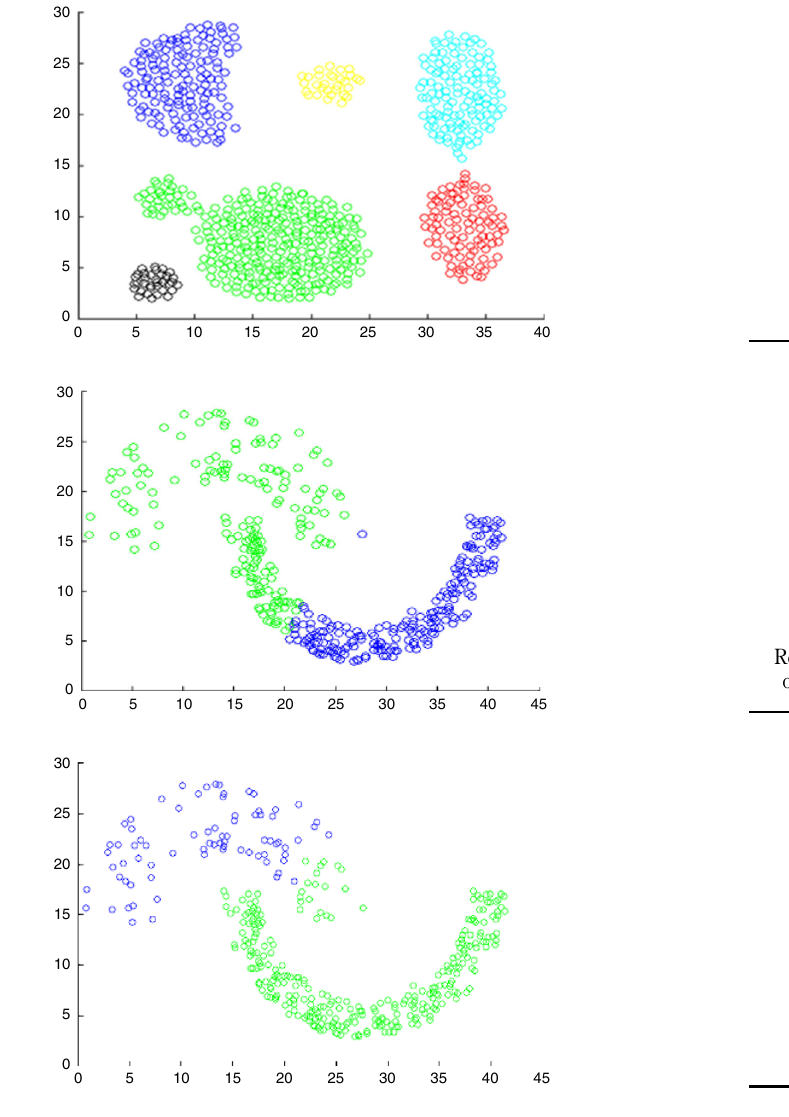
Figure 12. Result of K -means on “ Jain ” data set